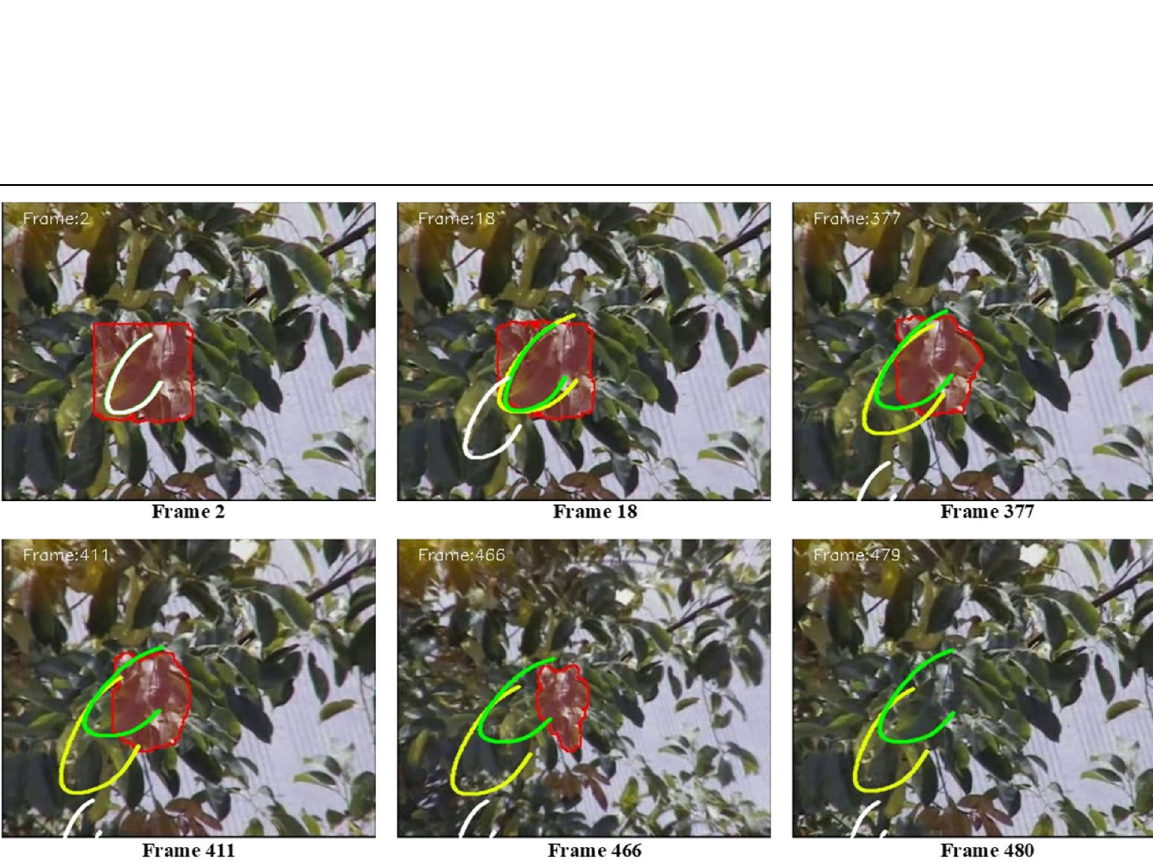
Fig. 8 Tracking result of Leaf2. Yellow — UKPF, white — MHMM-UPF, red — Hough Tracker, green — proposed